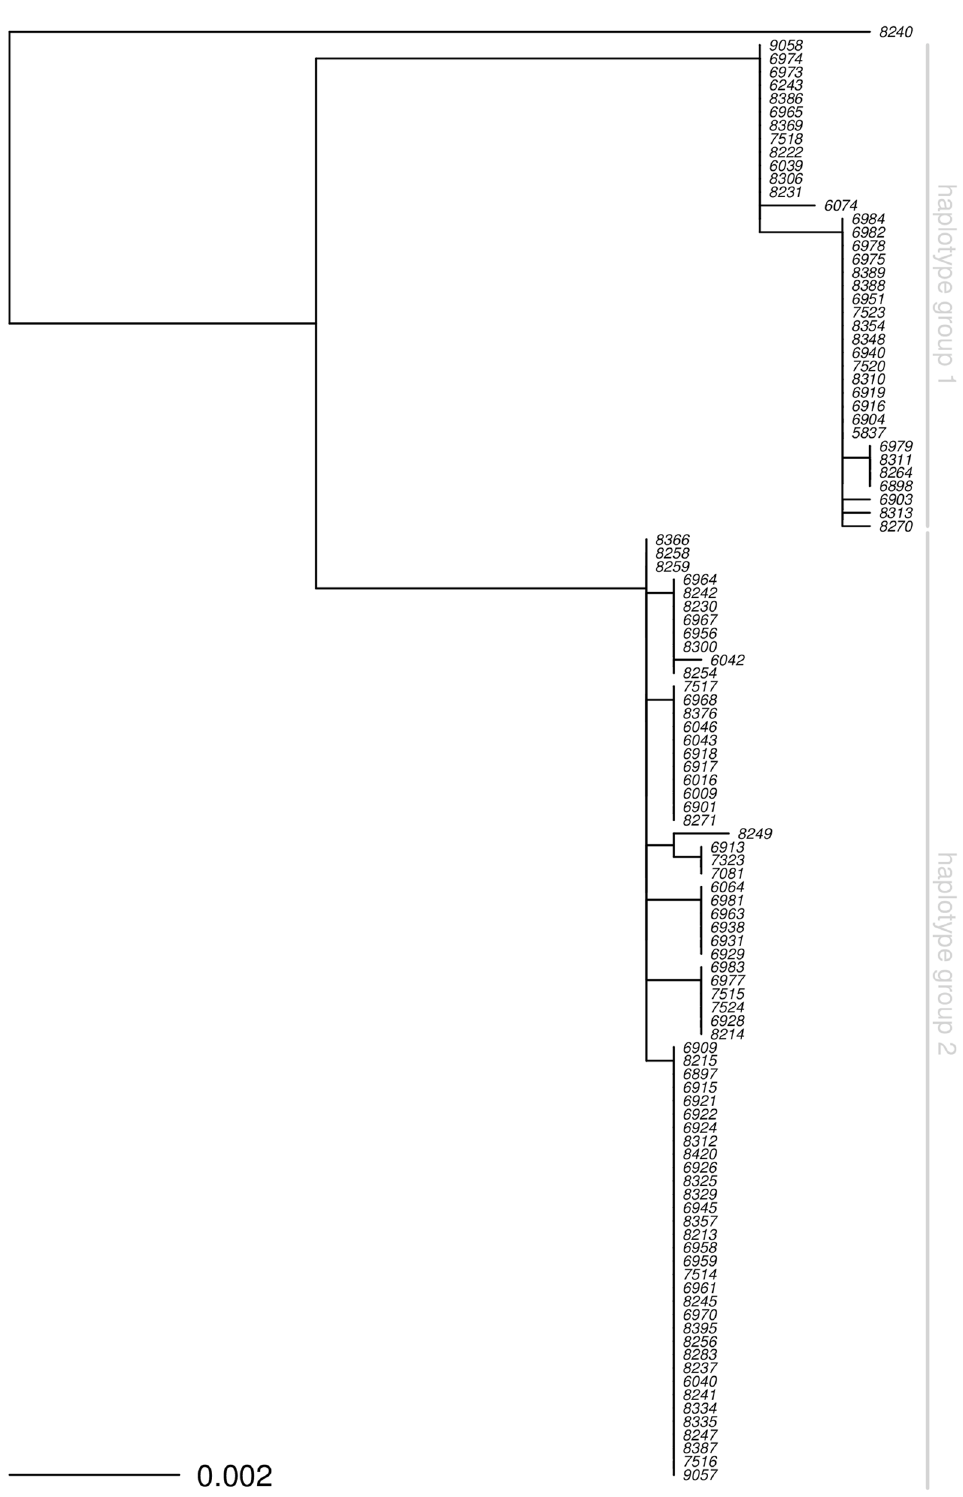
Fig 4. The maximum-likelihood phylogram of EFR protein coding sequence reveals two distinct haplotype groups. Phylogenetic analysis of 3,096 nucleotides of the EFR coding region of 109 A. thaliana genotypes that were also represented in the GWA mapping. The sequences were reconstructed from SNP data of the 1001 genome project (http://1001genomes.org/). All nodes are supported by 100 out of 100